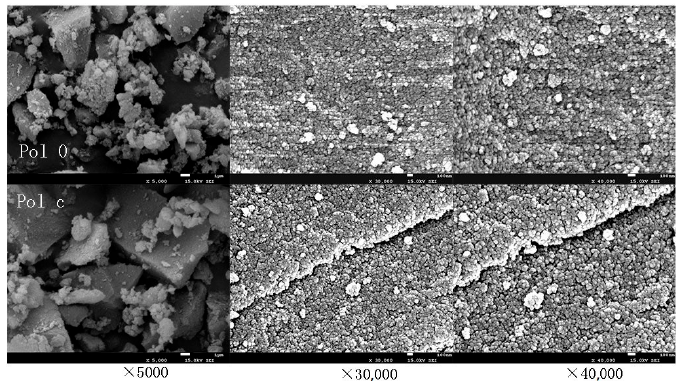
Figure 5. The SEM characterization of Pol 0 and Pol c.